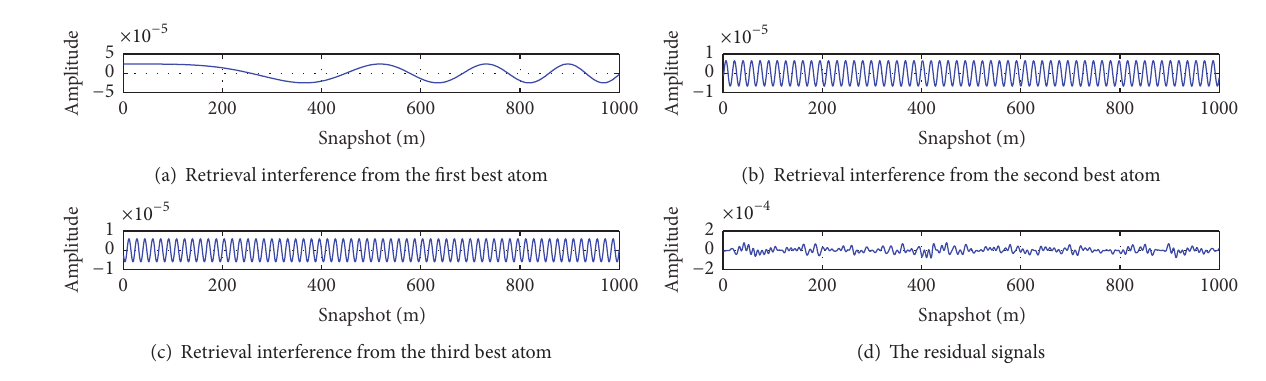
Figure 8: Time-domain waveform of estimated interfering signals.